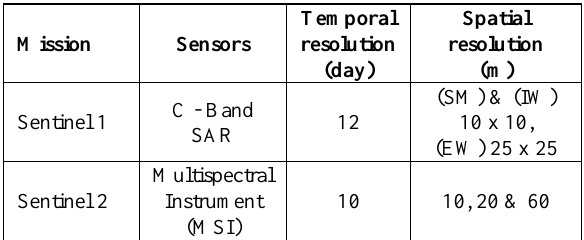
Table 1. The characteristics of Sentinel-1 and -2 data (Soille et al., 2016).